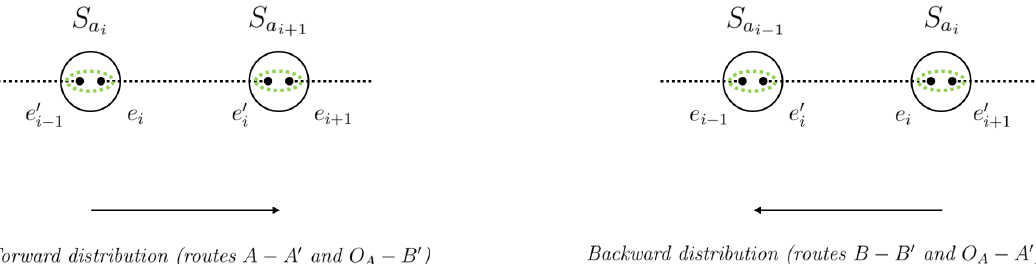
Figure 3. Creation of entangled pairs at each node from the subset of N active quantum switches. Depending on the position relative to middle stations A (cid:48) and B (cid:48) , a qubit is received from downstream or upstream, while one qubit of the generated pair is further sent to another node. Bell measurements (dotted ellipse around particles) will eventually be performed on qubits from different entangled